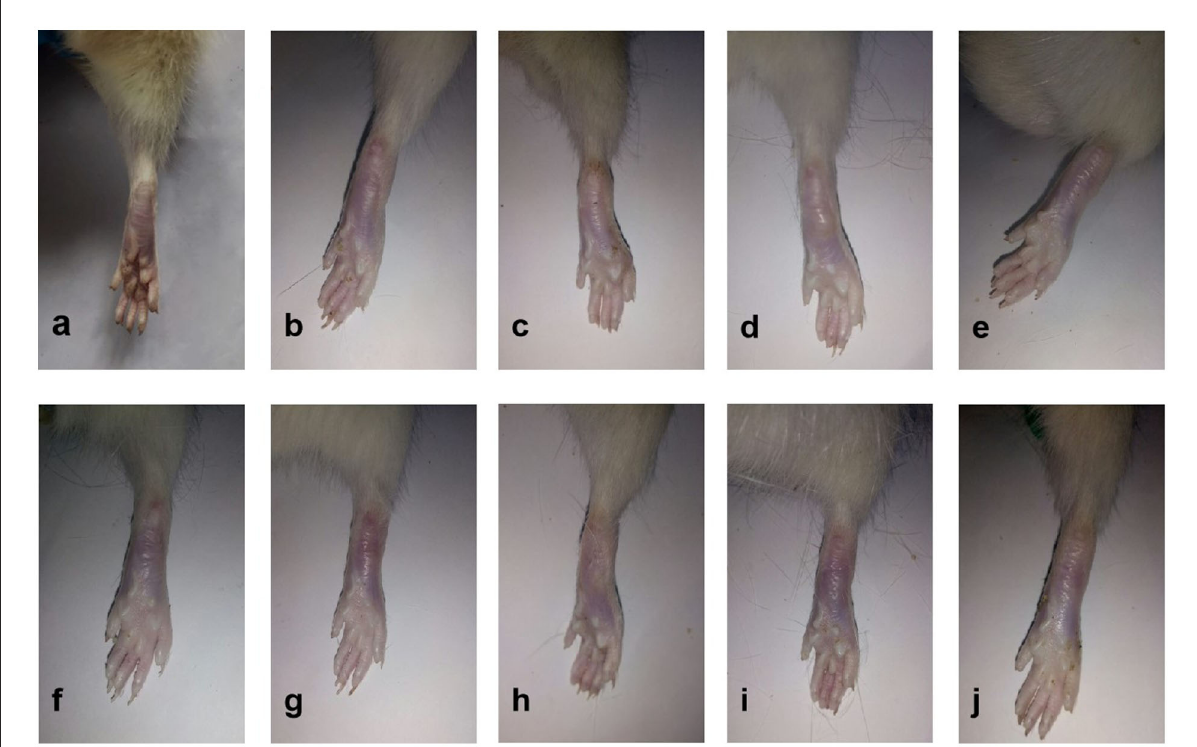
FIGURE3 The appearance of rats with CFA-induced adjuvant arthritis. (a) Normal control (Con) group; (b) model (CFA) group; (c) negative control (NC) group; (d) positive control (PC) group; (e) PCEO group; (f) PFEO group; (g) ROEO group; (h) SJEO group; (i) LAEO group; and (j) AREO